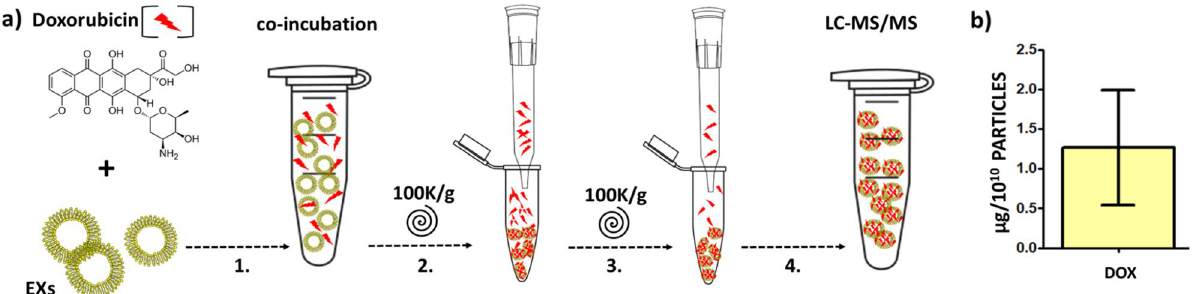
Figure 3. Slug EXs loading with DOX. ( a ) After co-incubation of DOX with EXs for 2 h at 37 °C, (1) two subsequent washing steps were applied to remove the residual unbound DOX. The mixture was ultracentrifuged for 30 min at 100,000× g , the supernatant containing the free DOX was discarded, the pellet containing the nanovesicles washed with PBS, resuspended in 1 ml of PBS, and this step was repeated (2.–3.) before quantification of the EXs-bound DOX by LC–MS/MS (4). ( b ) Resulting uptake of the DOX per 10 10 .